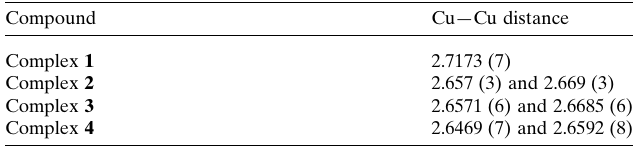
Table 1 Metal–metal distances (A˚ ) in complexes 1 – 4